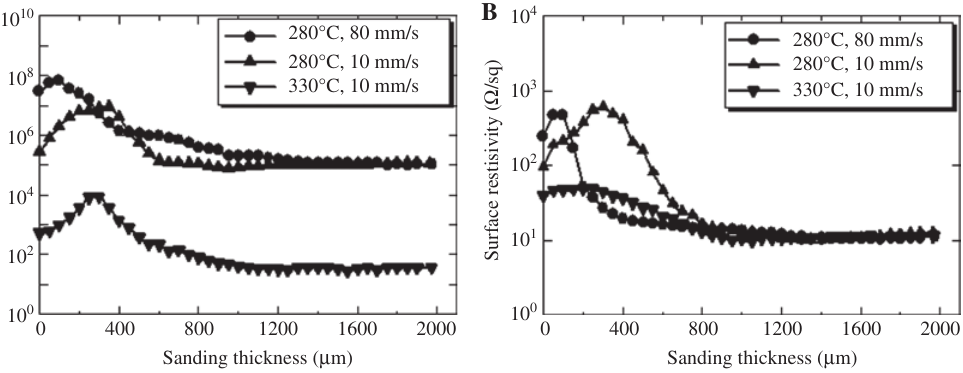
Figure 11: Distributions of surface resistivity of the MWCNT/PC composites with (A) 5 wt.% MWCNTs and (B) 10 wt.% MWCNTs.